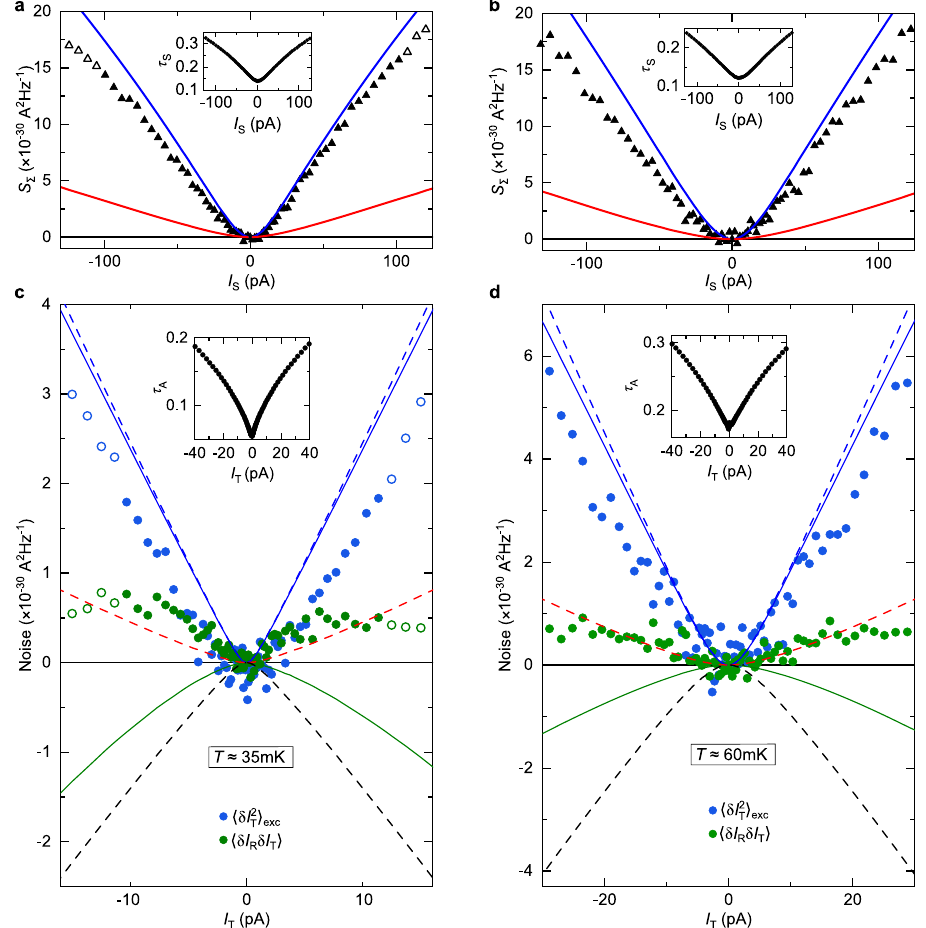
Fig.10|SupplementaryobservationsinthesourceSBS-analyzerSBSregime.a,b,c,d Thedisplayeddata(symbols)corroboratetheobservationsshowninFig.3b,d for distinct device tunings, and also at the higher temperature T ≈ 60 mK ( b, d ). The data in ( a ) and ( c ), and in ( b ) and ( d ) were measured